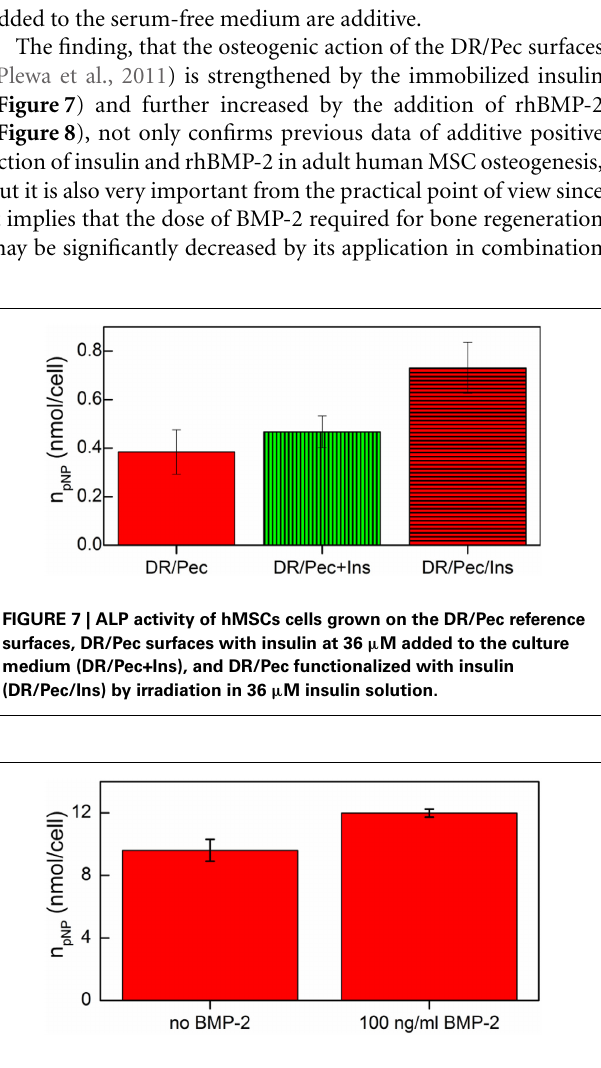
FIGURE 8 | ALP activity of hMSCs cells grown on DR/Pec/Ins supports in the absence and in the presence of BMP-2 on day 7 of the culture in a serum-free